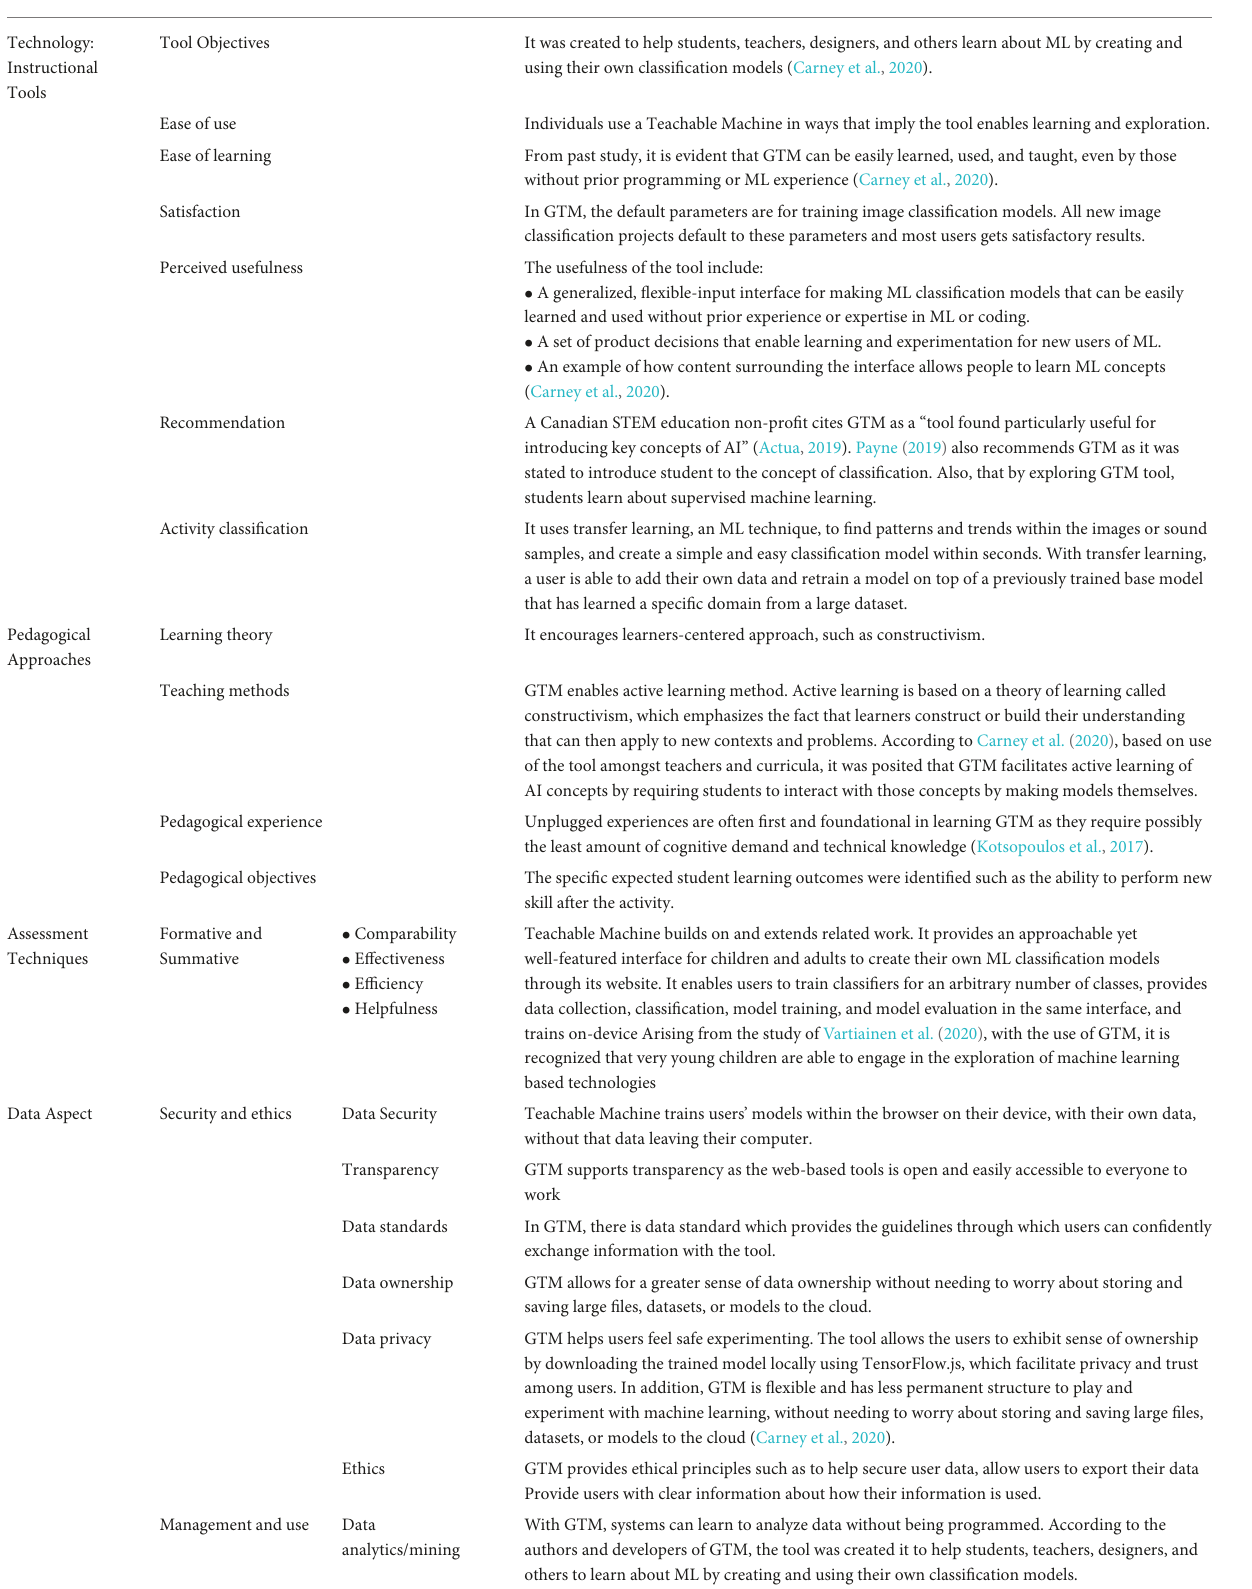
TABLE 4 Evaluation of Google Teachable Machine based on